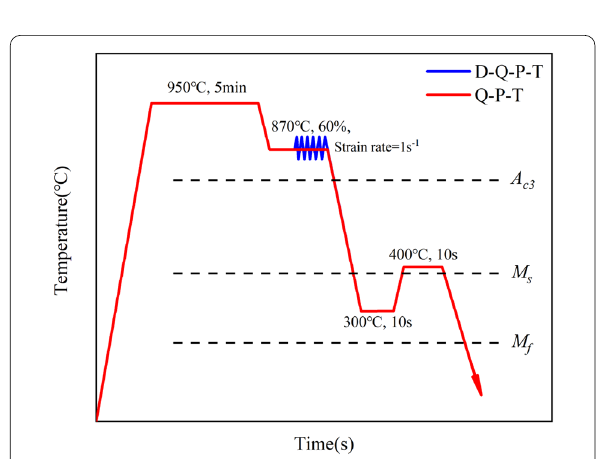
Figure 4 The first group of experiments